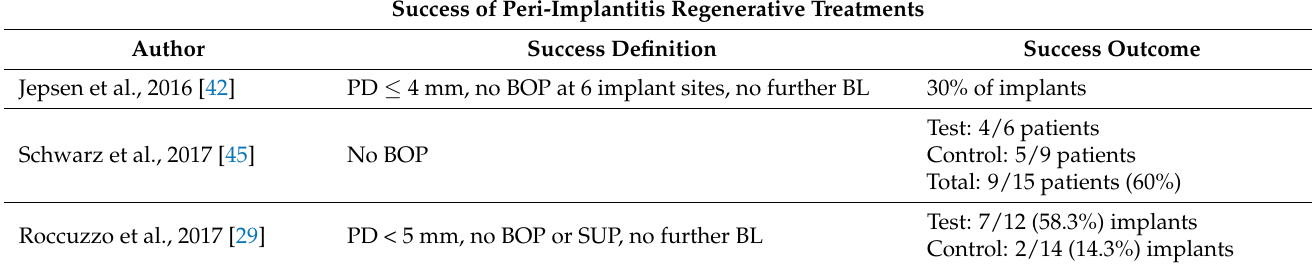
Table 2. The success of regenerative treatment reported by the listed authors. As it is noted, the criteria vary among studies, making the concept of treatment success difficult to standardize. PD (Probing Depth); BL (Bone Loss); BOP (Bleeding on Probing); SUP (Suppuration); RF (Radiographic Fill); DF (Defect Fill). Adapted from Ramanauskaite et al.